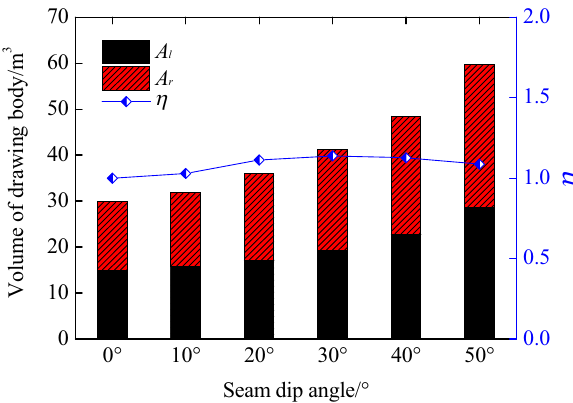
Fig. 17 Variations of drawing body volume and volume symmetry coefficient with seam dip angle